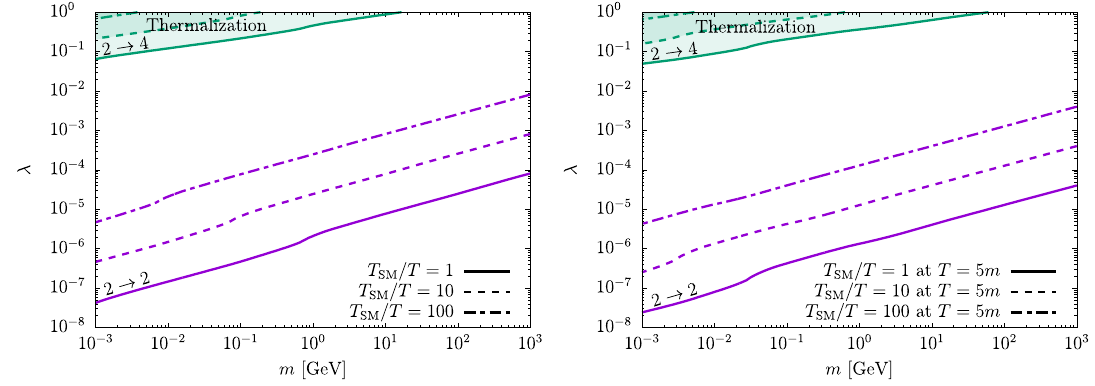
Figure 10 . Couplings consistent with thermalization in the non-relativistic regime. The tempera- ture ratio is fixed at T 0 = m/ 5 (left) and T 0 = 5 m